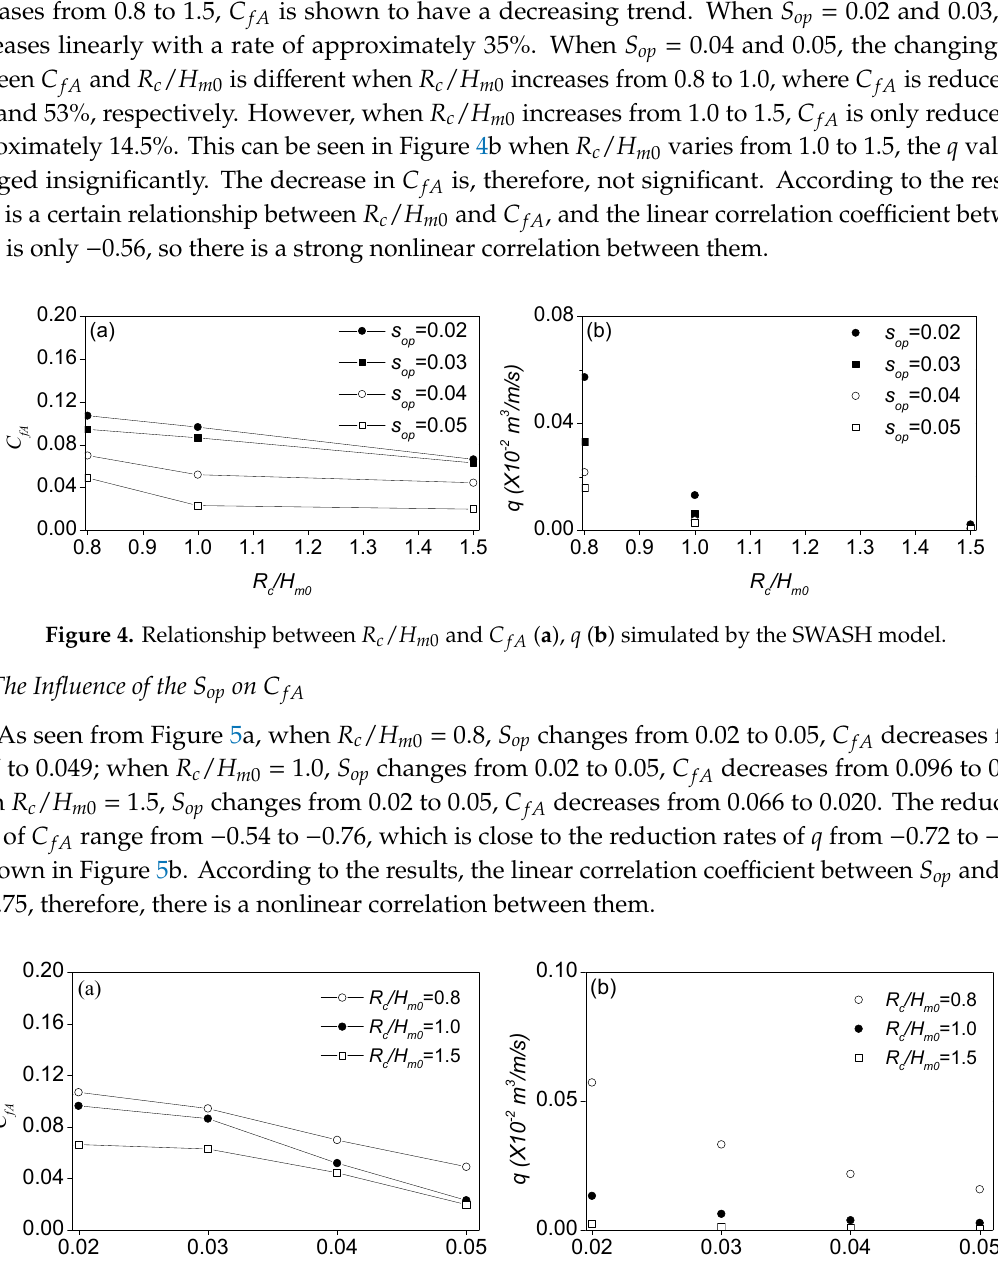
Figure 3. Comparison of different empirical formulas and physical model tests.